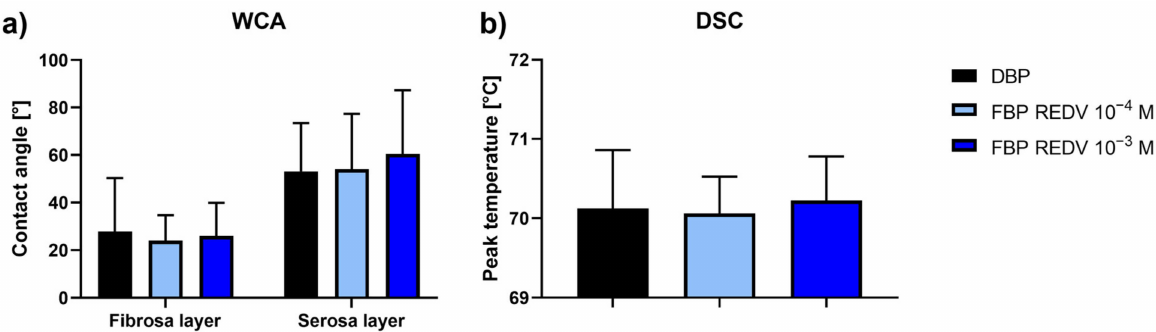
Figure 3. WCA and DSC analyses. ( a ) Water contact angle measurements on the functionalized serosa and fibrosa sides of DBP (functionalized bovine pericardium, FBP); ( b ) differential scanning calorime- try (DSC) peak temperature of functionalized DBPs in the hydrated state recorded at 20 ◦ C/min between 25 ◦ C and 90 ◦